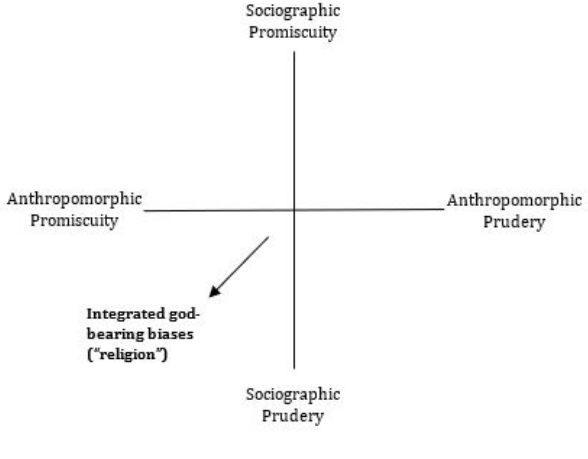
Figure 1: The integration of theogonic